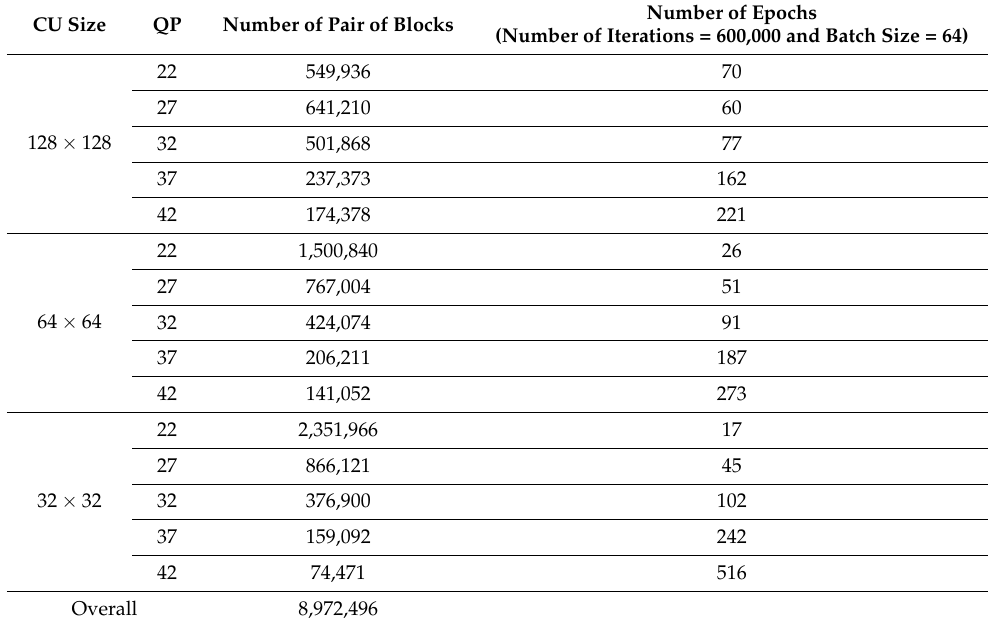
Table 3. The number of pair of blocks for each type of training